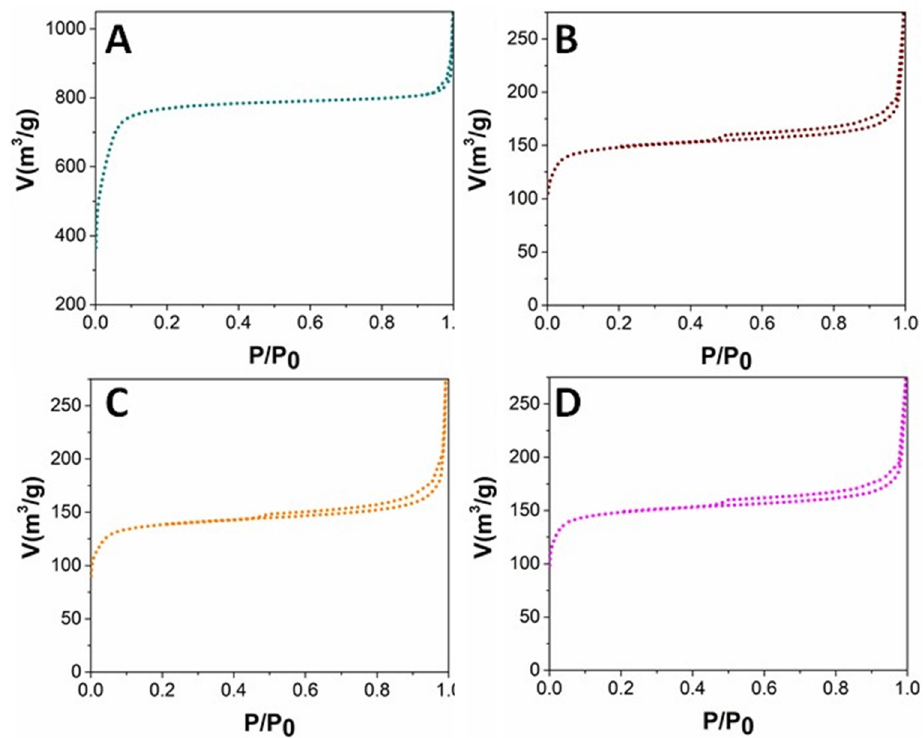
Figure 1. N 2 adsorption–desorption isotherms of ( A ) UiO-66, ( B ) 1%Ni/UiO-66, ( C ) 3%Ni/UiO-66, ( D ) 5%Ni/UiO-66.